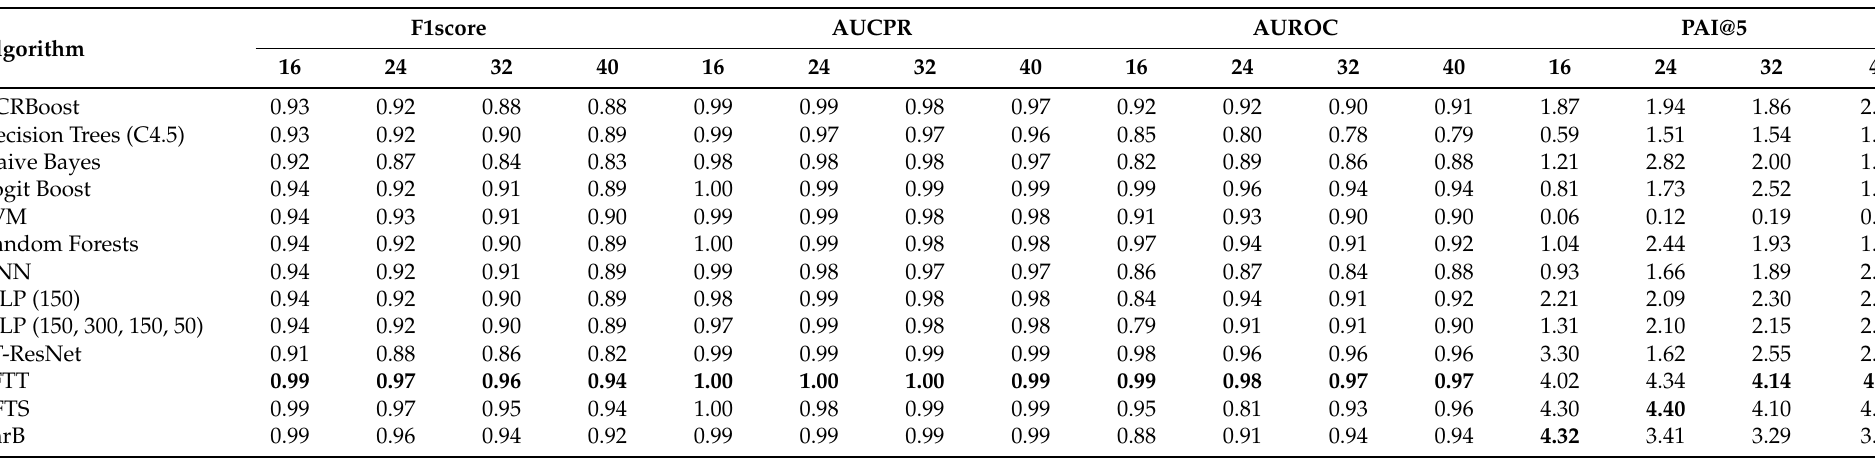
Table 4. F1score, Precision-Recall AUC, ROC AUC and PAI@5 for different p (i.e., different resolutions) in the Philadelphia dataset for “All Crimes” crime type. The winning algorithm is in